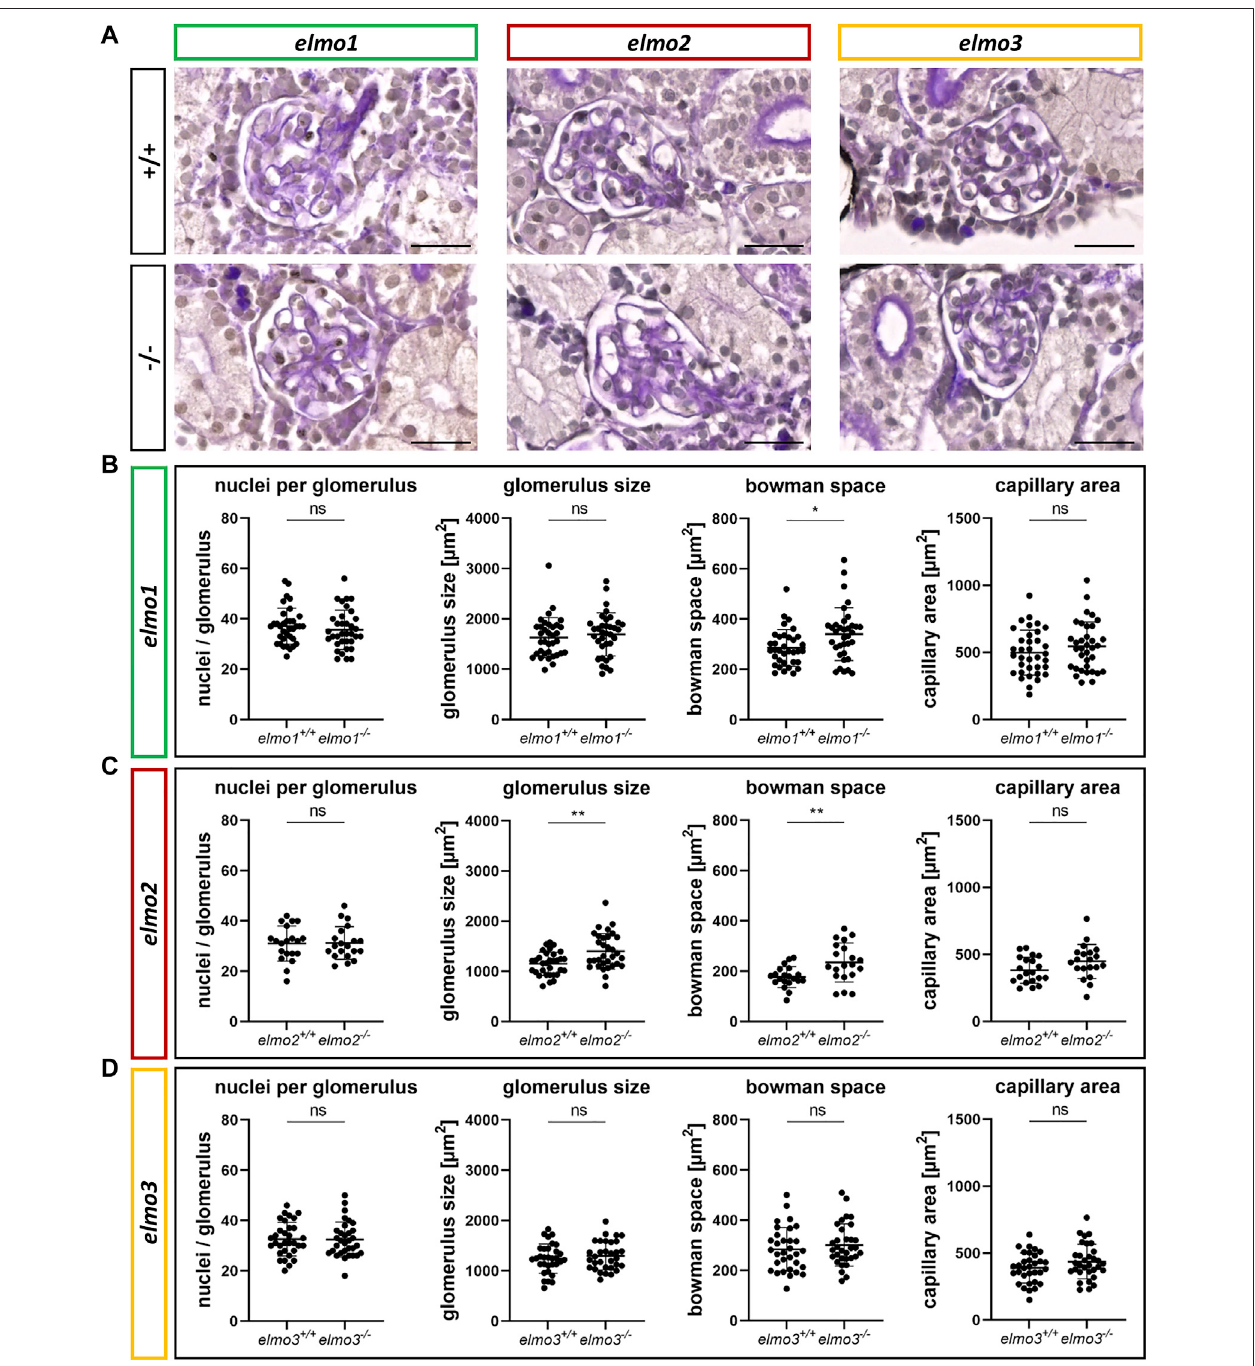
FIGURE 4 | Different regulation of the glomerular structure through Elmo1, Elmo2 and Elmo3 in the kidney of adult zebra fi sh. (A) Representative light microscopy imagesofPASstainedsectionsofglomeruliinthekidneyof elmo1 +/+ and elmo1 − / − , elmo2 +/+ and elmo2 − / − and elmo3 +/+ and elmo3 − / − adultzebra fi sh(9 – 13 mpf).Scale bar is 20 µm. (B) Analysis of the glomerulus structure in adult zebra fi sh kidneys showed no changes in the number of nuclei, glomerulus size and capillary area but an increase in the bowman space in elmo1 − / − compared to elmo1 +/+ . n = 35 glomeruli per group, always seven glomeruli per kidney. (C) Analysis of the glomerulus structure in adult zebra fi sh kidneys showed no changes in the number of nuclei and the capillary area but an increasein glomerulus size and bowman space in elmo2 − / − compared to elmo2 +/+ . n = 20 glomeruli per group, always fi ve per kidney. (D) Analysis of the glomerulus structure in adult zebra fi sh kidneys showed no alterations in elmo3 − / − compared to elmo3 +/+ . n = 32 glomeruli per group, always eight per kidney. Statistical analysis was done with t -test and Mann-Whitney test. * p < 0.05, ** p < 0.01. ns, not signi fi cant; mpf, months post fertilization.